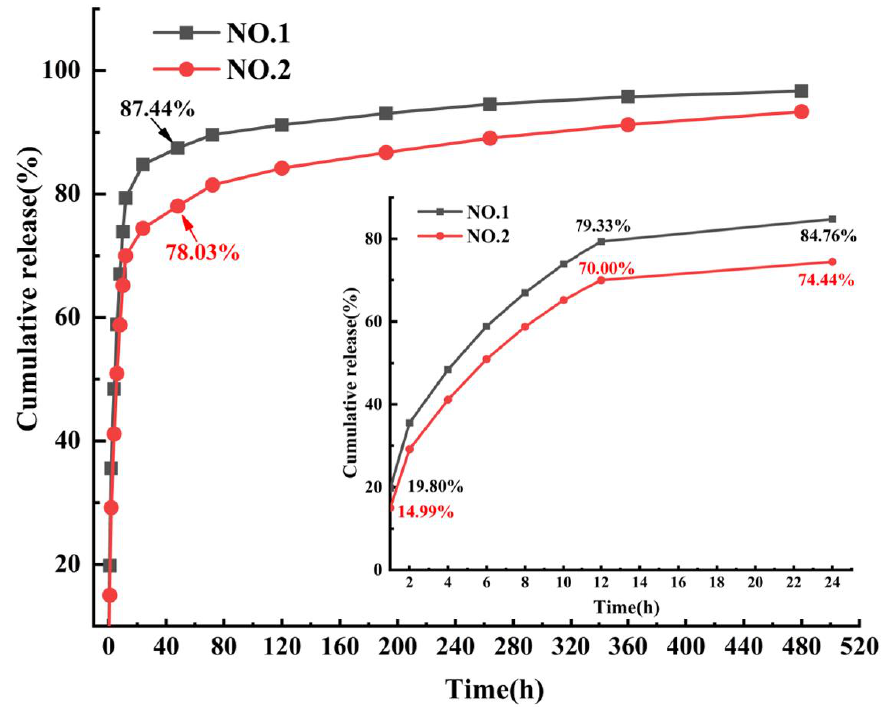
Figure 7. SIM release curves of NO.1 and NO.2 NFMs.